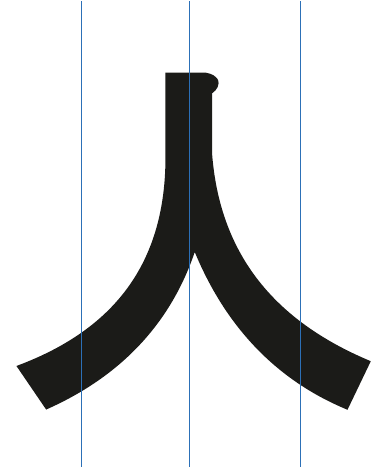
Figure 4: Vertical stroke density feature extraction.